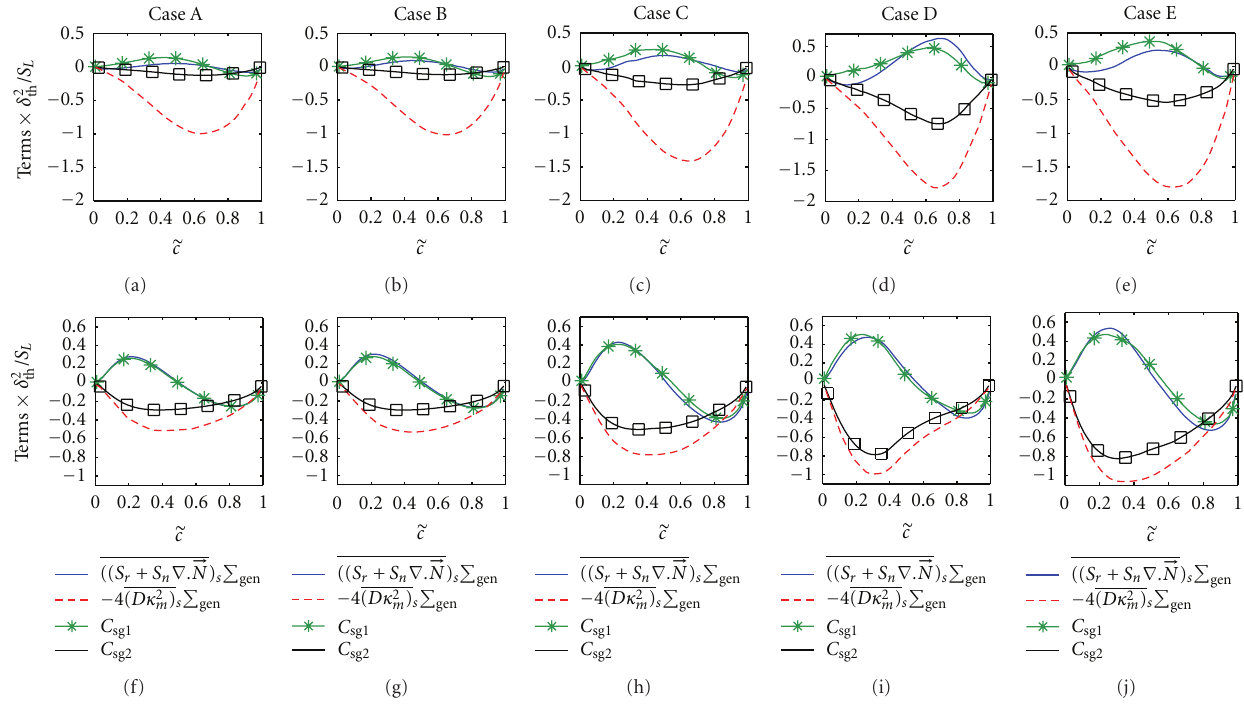
(cid:2) N Figure 3: Variations of (( S r + S n ) ∇ · ) s Σ gen , − 4( Dκ 2 m ) s Σ gen , C sg1 , and C sg2 conditionally averaged in bins of (cid:3) c across the flame brush for . 8 δ Δ = 24 Δ . 4 δ Δ = 8 Δ m ≈ 0 m ≈ 2 th (top row) and th (bottom row) for cases A (1st column), B (2nd column), C (3rd column), D (4th column), and E (5th